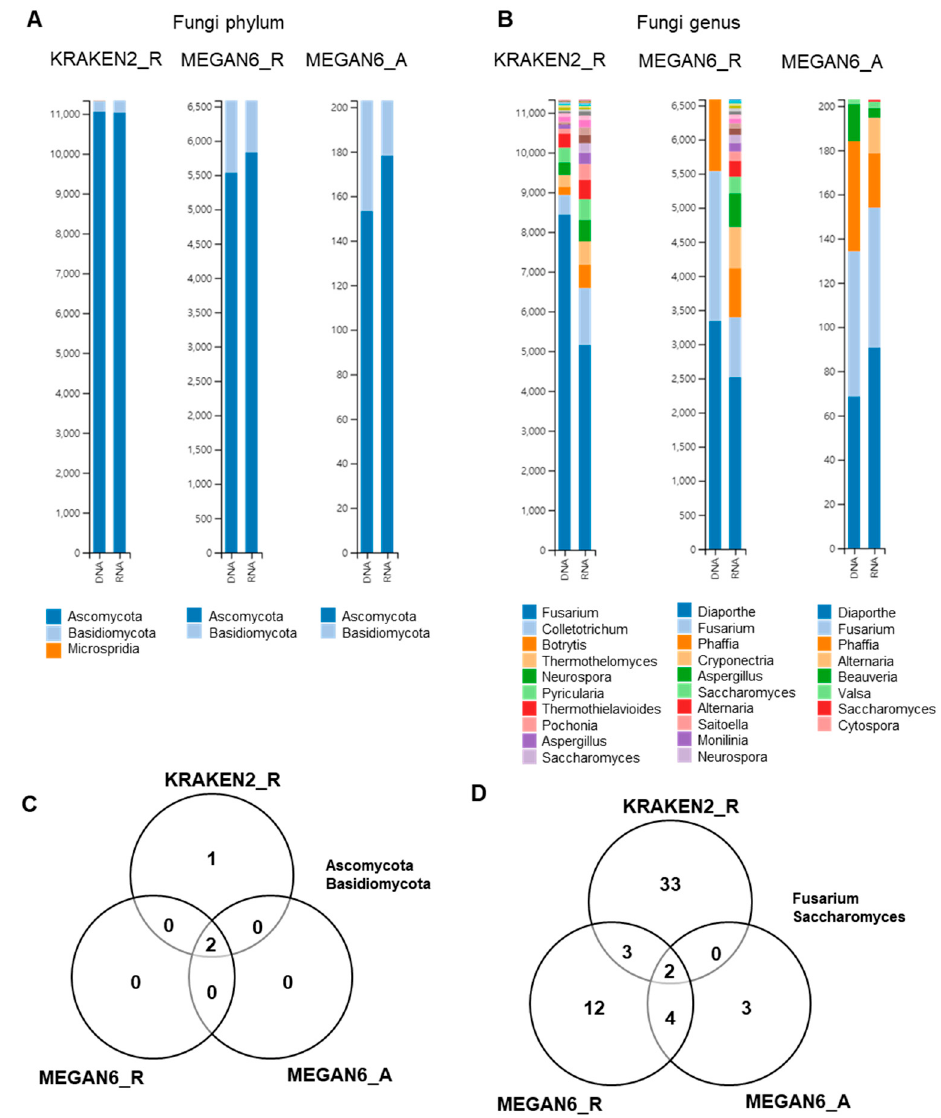
Figure 9. Comparison of identified fungi at phylum and genus levels by three different analytical methods (i.e., KRAKEN2_R, MEGAN6_R, and MEGAN6_A). Proportion of identified fungal phyla ( A ) and genera ( B ). Commonly identified phyla ( C ) and genera ( D ) among three different analytical methods.